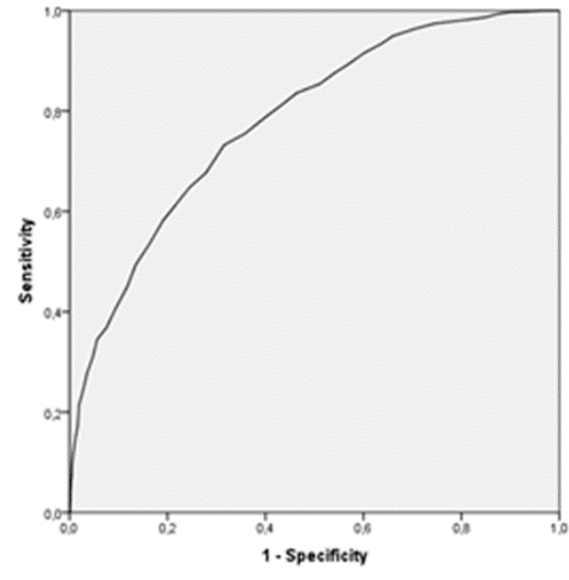
Figure 1. Receiver operating characteristics (ROC) curve. Criterion variable: self-dependence perception.